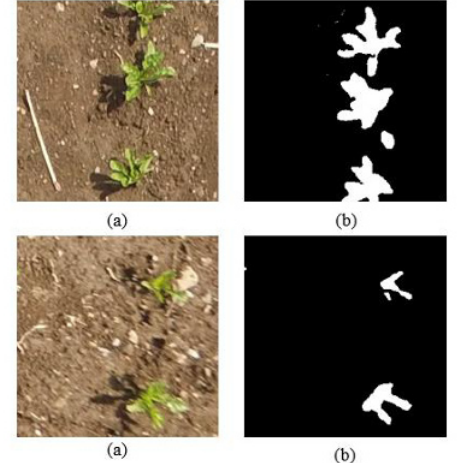
Fig. 4. Example of Mask creation of the used images.